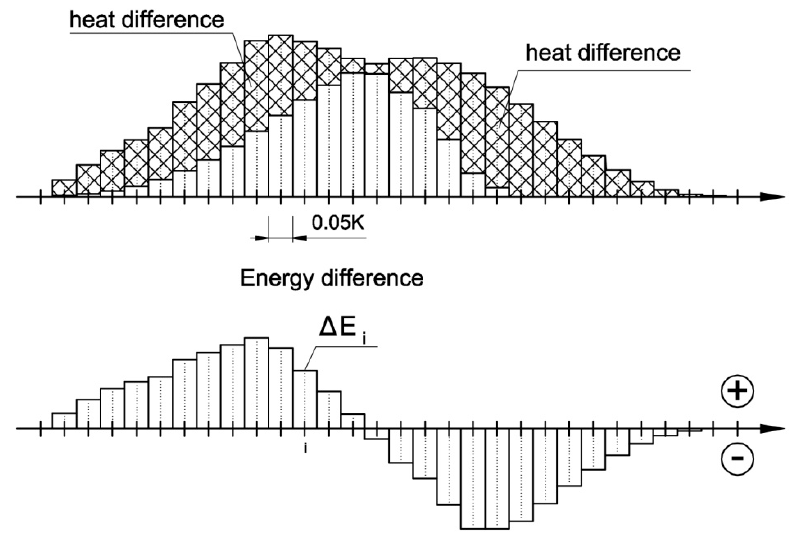
Figure 10. Energy difference between the energy distribution graph and the shifted energy distribution graph.